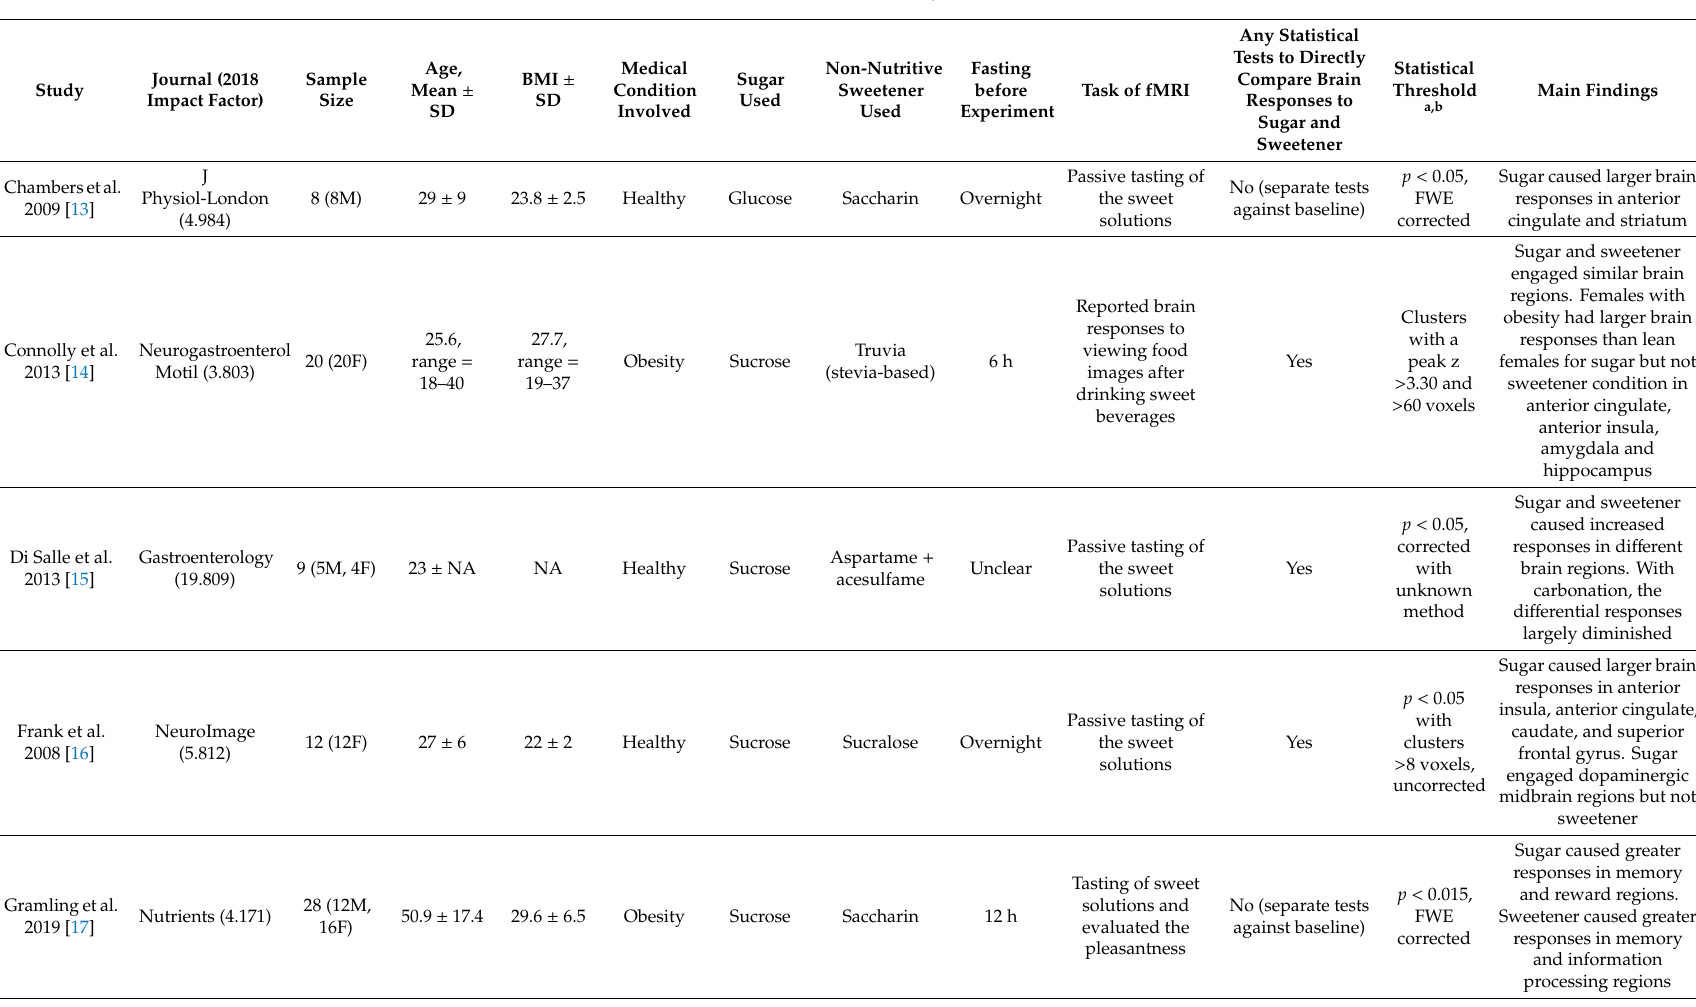
Table 1. Details of the 20 analyzed